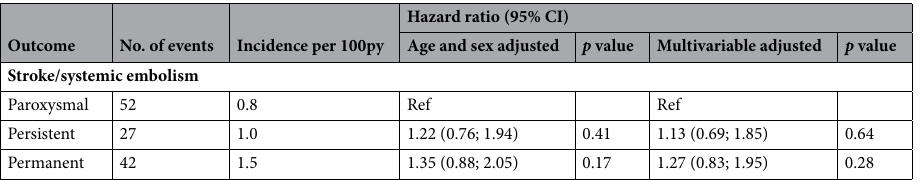
Table 2. Risk of stroke/systemic embolism according atrial fibrillation type. Data are hazard ratios (HR) (95% confidence intervals [CI]). p-values were based on Cox regression models. No. number, Ref. reference, py patient years. P-values are based on Cox regression models. Multivariable models were adjusted for age, sex, heart rate and time-updated: smoking status (current vs. history/never smoker), BMI, history of diabetes, history of coronary artery disease, history of hypertension, history of heart failure, history of stroke and/ or transient ischemic attack, history of renal failure, oral anticoagulation, antiplatelet therapy, history of pulmonary vein isolation and history of electrical cardioversion.